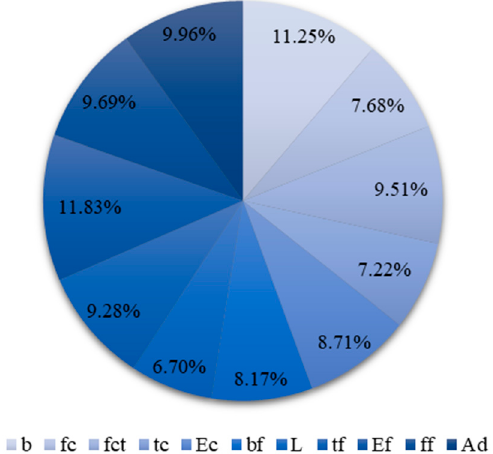
Figure 9. Contribution of the input parameters.